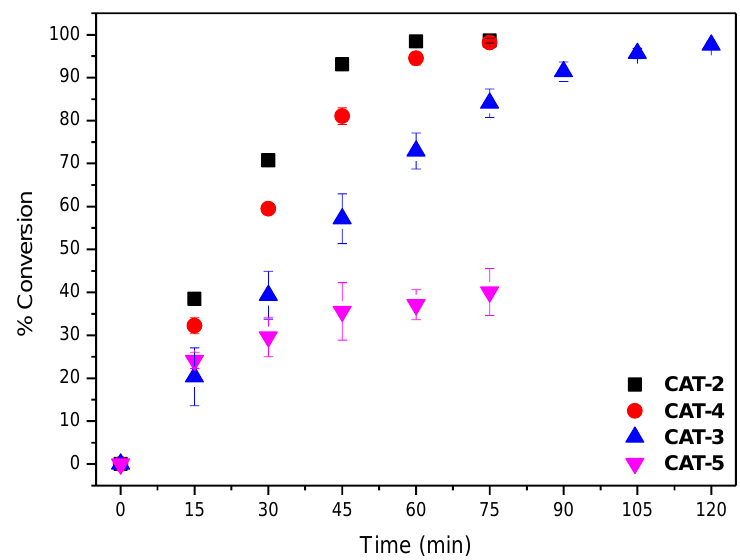
Figure 10. Cyclooctene conversion in the oxidation reactions catalysed by different Mn(III) porphyrin catalysts vs. time for an S/C molar ratio of 600. Data correspond to the mean values of at least three non-simultaneous replicates and the vertical bars correspond to the standard deviations.